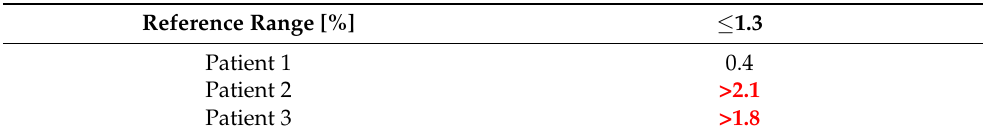
Table 2. Levels of transferrin in our patients with ALG13 c.320A>G variant and abnormal IEF pattern (values exceeding the reference range are marked with red).